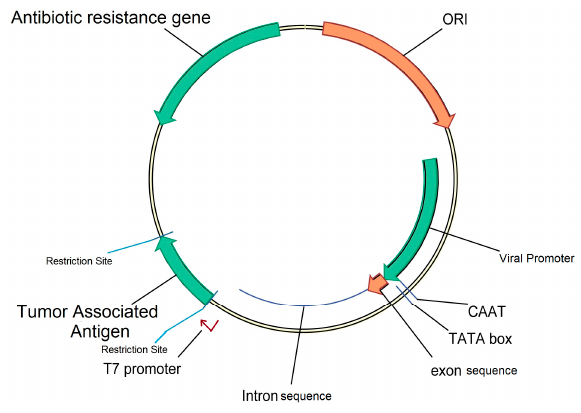
Figure 2. Generic structure of the plasmid backbone for DNA Vaccine. ORI, origin of replication; Colors represented in green are usually inserted into the vector backbone; color represented in green usually are already present in the vector backbone.